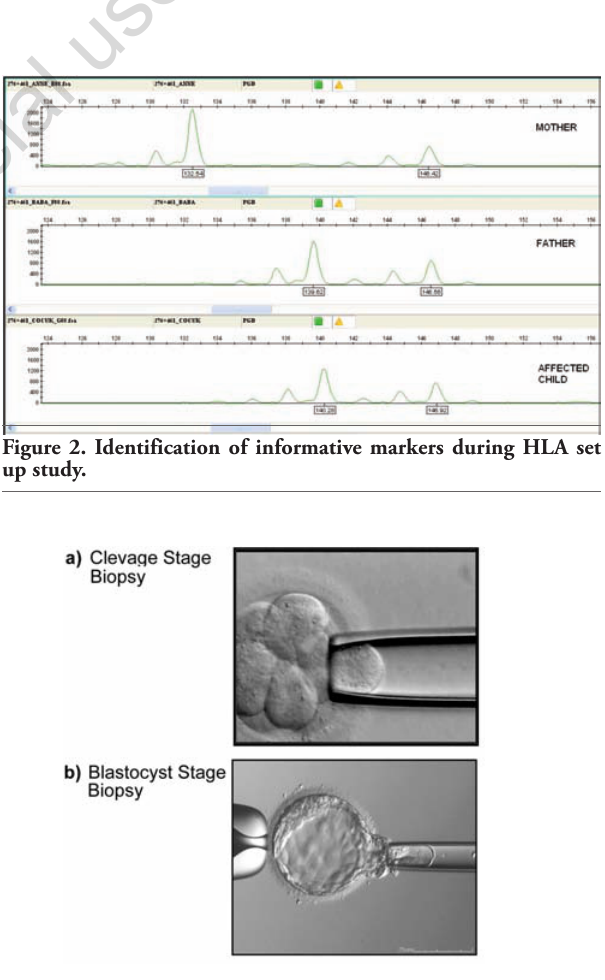
Figure 3. Biopsy